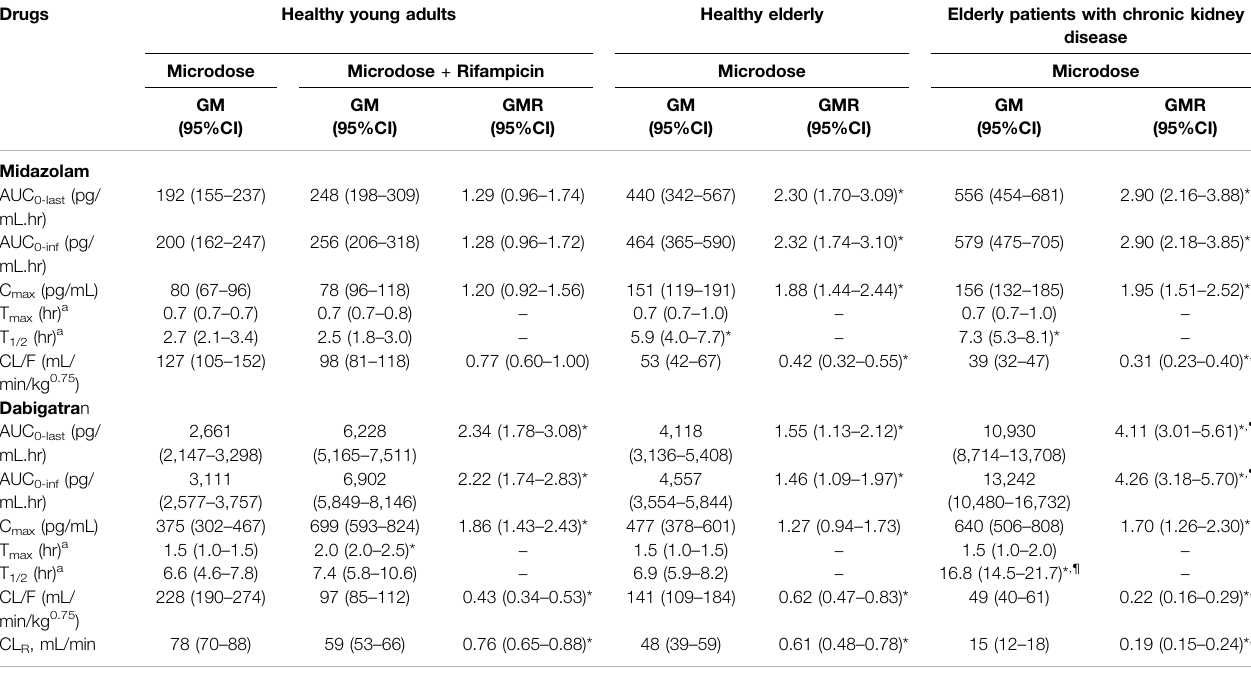
TABLE 2 | Pharmacokinetic parameters of midazolam and dabigatran.